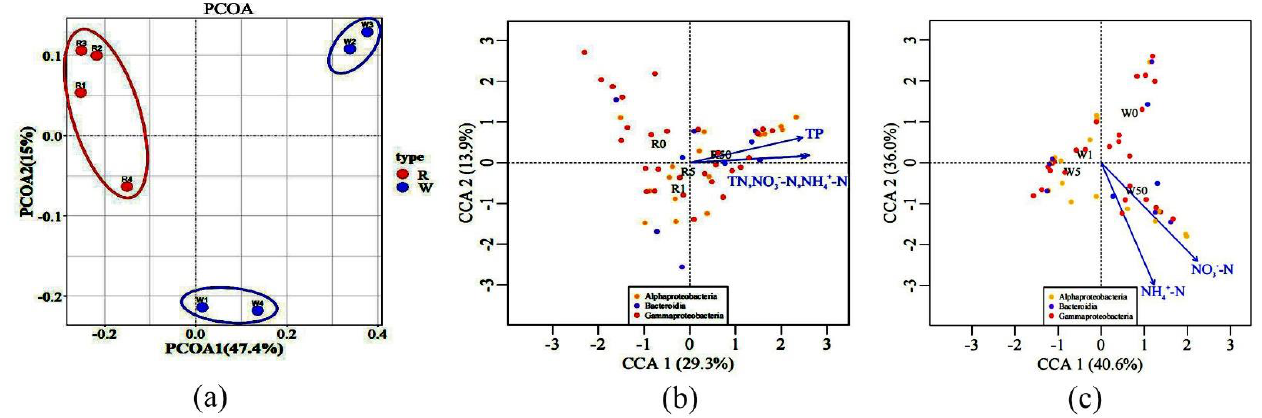
Figure 6. Principal coordinate analysis (PCoA) of bacteria in all treatments based on the Bray–Curtis distance matrix ( a ). Plot of the canonical correlation analysis (CCA) integrating environmental factors (TN: total nitrogen; NO 3− -N: nitrate nitrogen; NH 4+ -N: ammonia nitrogen; and TP: total phosphorus) and metabolic activities of the bacterial groups, including Alphaproteobacteria, Bacteroidia, and Gammaproteobacteria. Only environmental factors with significant correlation ( p < 0.05) are shown in the figure, including the rhizosphere ( b ) and water samples ( c ).